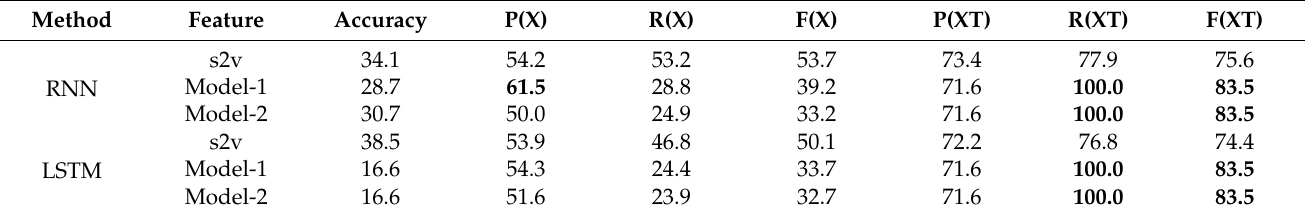
Table 15. Comparison with the other methods presented in DBDC2